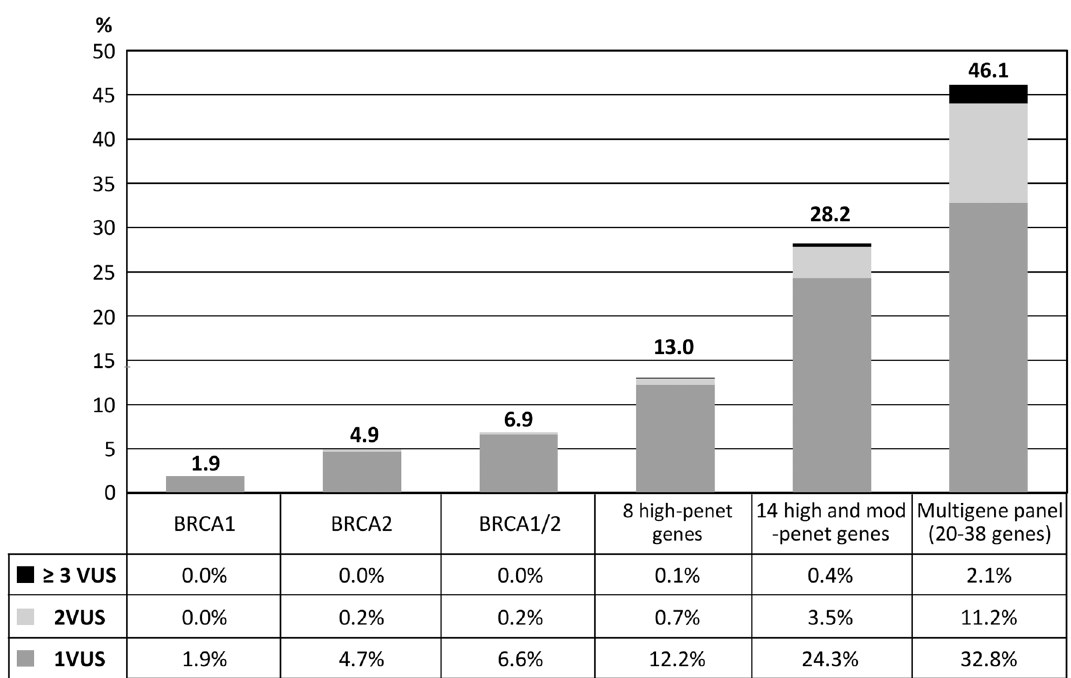
Figure 3. Frequency of variants of unknown significance (VUS). Cumulative fraction of clinical cases with one or more VUS, irrespective of pathogenic variants observed, as the scope of testing increases. High-penetrant genes: BRCA1 , BRCA2 , CDH1 , NF1 , PALB2 , PTEN , STK11 and TP53 ; moderate-penetrant genes: ATM , BARD1 , BRIP1 , CHEK2 , RAD51C and RAD51D